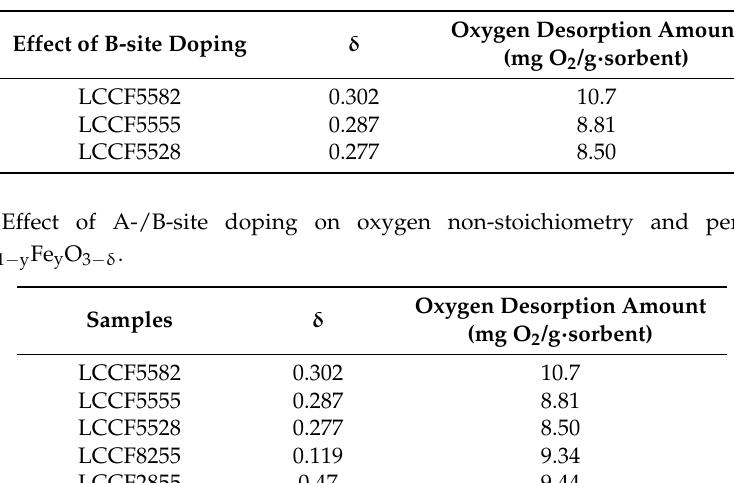
Table 5. Effect of B-site doping on δ and performance of La 0.5 Ca 0.5 Co 1 − y Fe y O 3 − δ (y = 0.2, 0.5, 0.8).